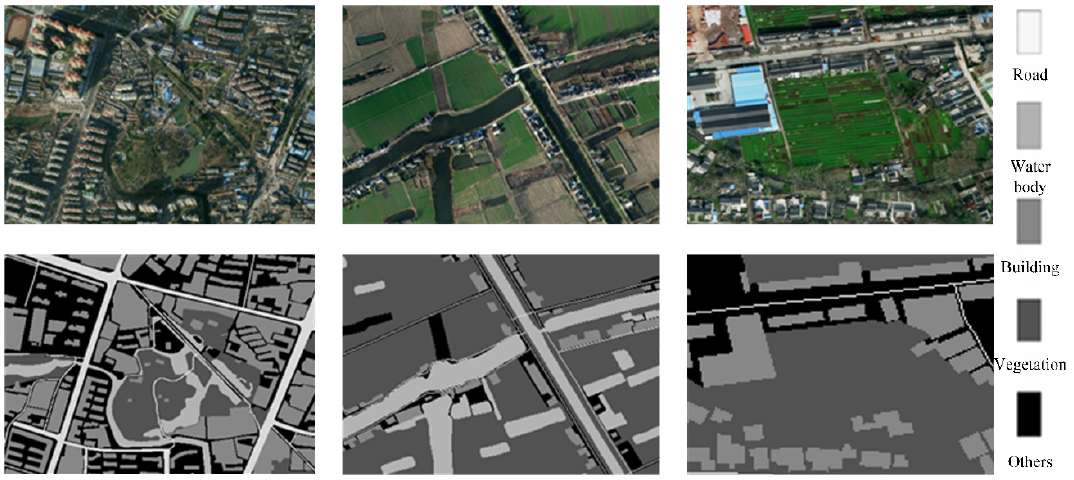
Figure 5. Partial training set and labels.